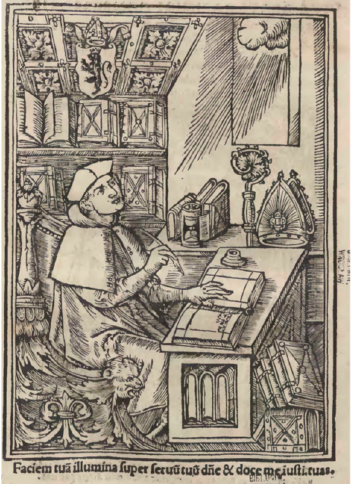
Figure 1. Portrait of Zaccaria Ferreri. In (Ferreri 1521a). Image in the public domain.